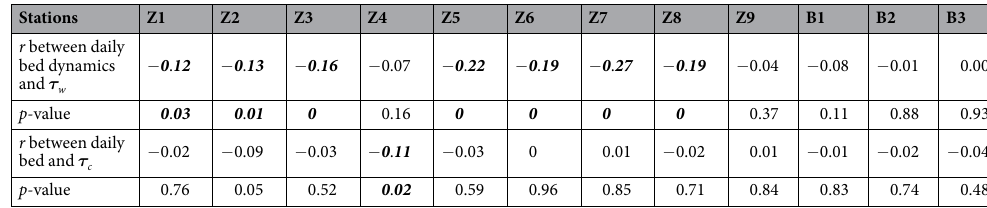
Table 1. The correlation between daily bed dynamics and wave/tidal forcing at each station. Significant correlations are indicated by bold and italic fonts to enable easy visual